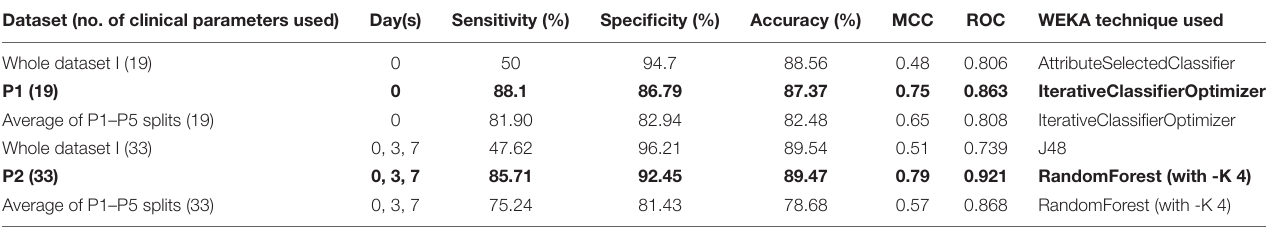
TABLE 1 | Performance of best models based on whole clinical parameters. Dataset (no. of clinical parameters used) Day(s) Sensitivity (%) Specificity (%) Accuracy (%) MCC ROC WEKA technique used Whole dataset I